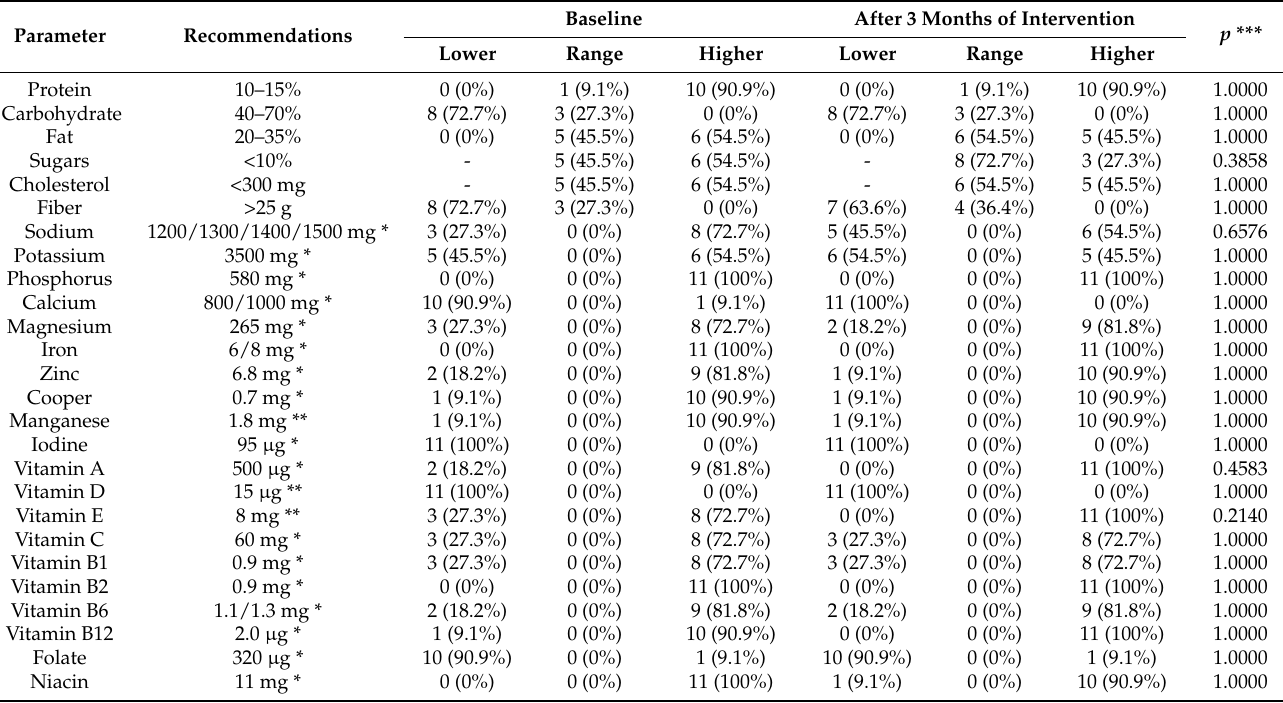
Table 6. The nutritional value of the diet compared with the recommended values depending on the age of the female participants at baseline and after 3 months of